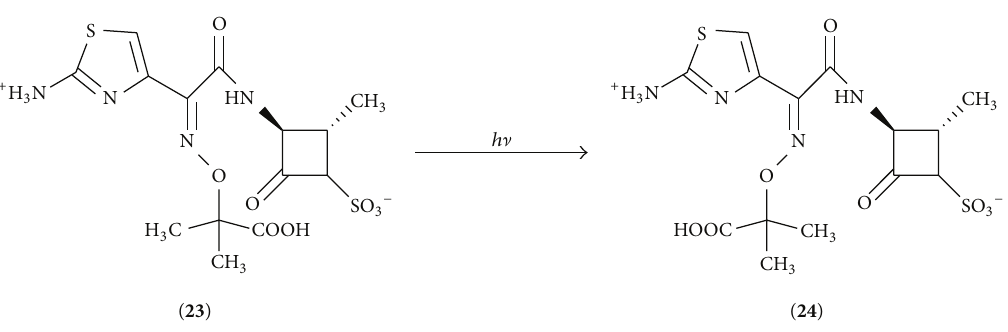
Figure 9: Photoisomerization reaction of